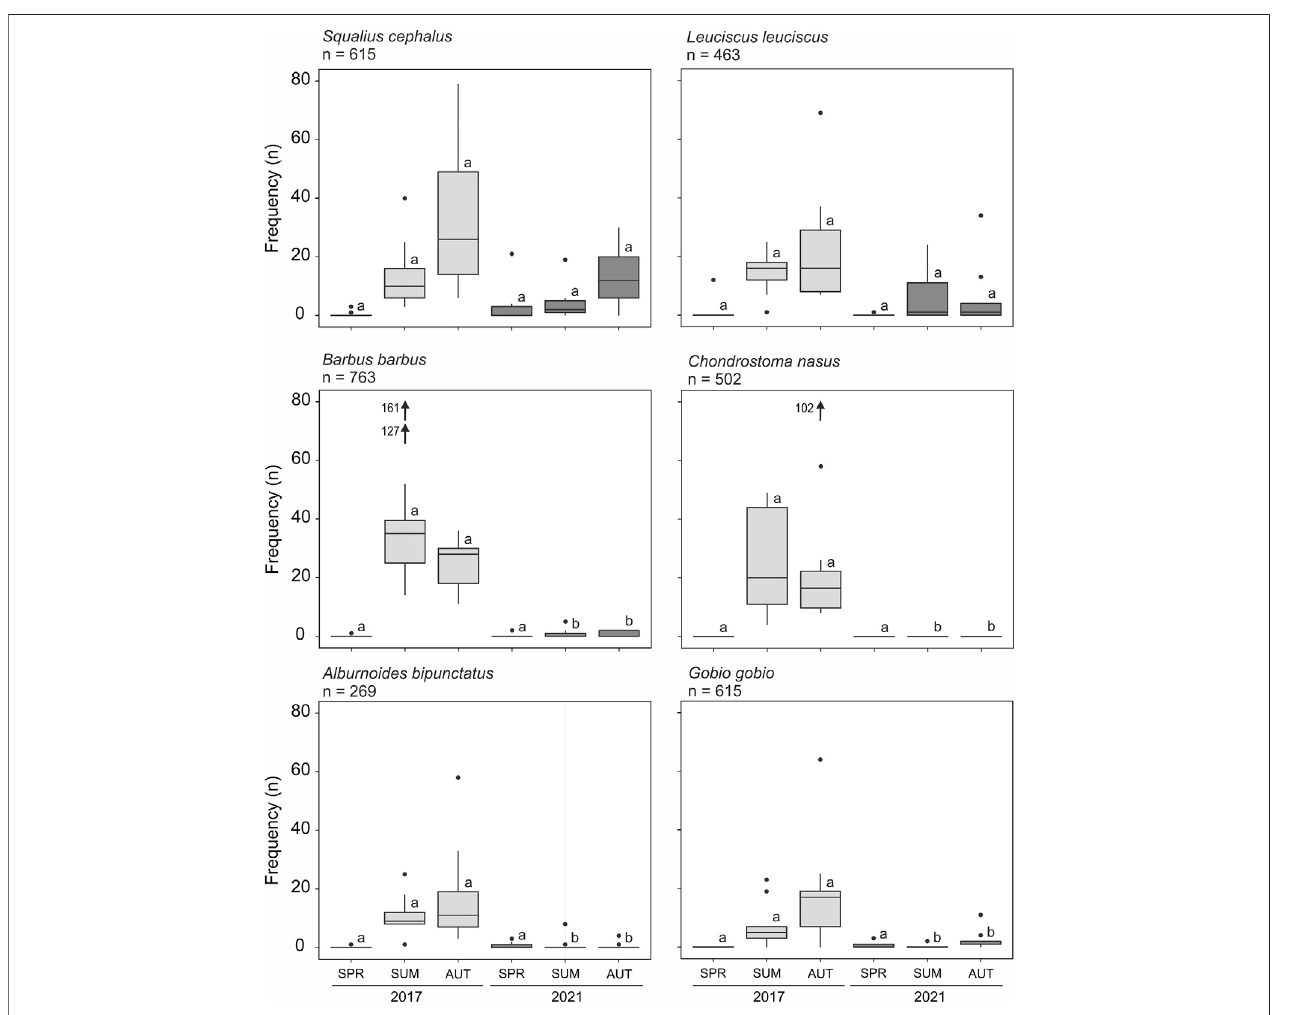
FIGURE 7 | Box – whisker plots presenting individual frequencies (n) of selected species separated by season and year before (light grey boxes) and after the dewatering (dark grey boxes). Each box refers to nine replicates of the sampled bank habitats. Different small letters above boxes indicate signi fi cant differences of pairwise comparisons of sampled seasons between 2017 and 2021. SPR = spring, SUM = summer, and AUT = autumn. Box = 25% quantile, median, 75% quantile; whisker = minimum, maximum values. Black arrows indicate